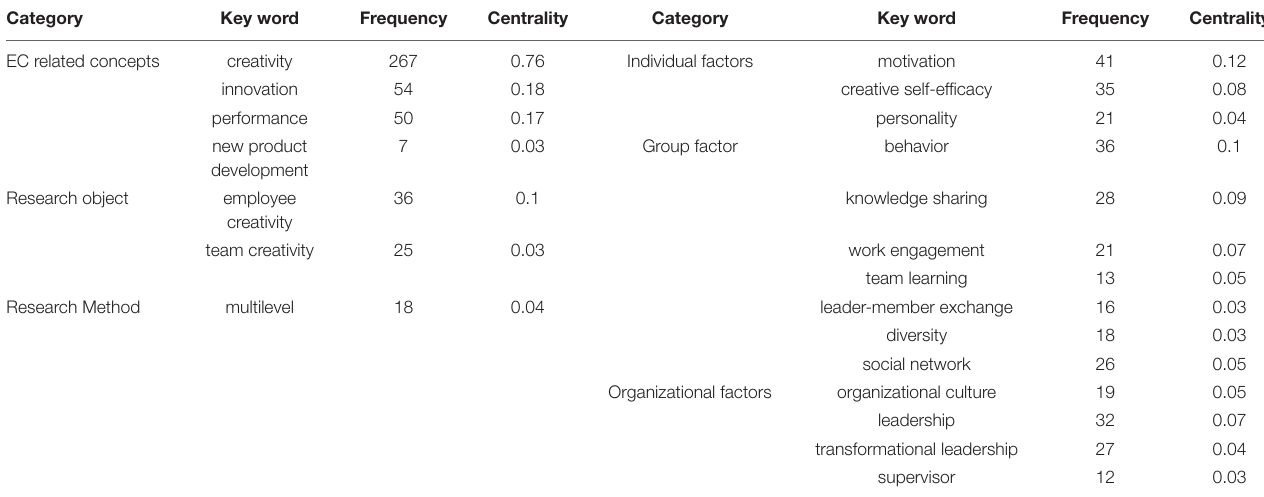
TABLE 4 | High-frequency keywords based on co-word